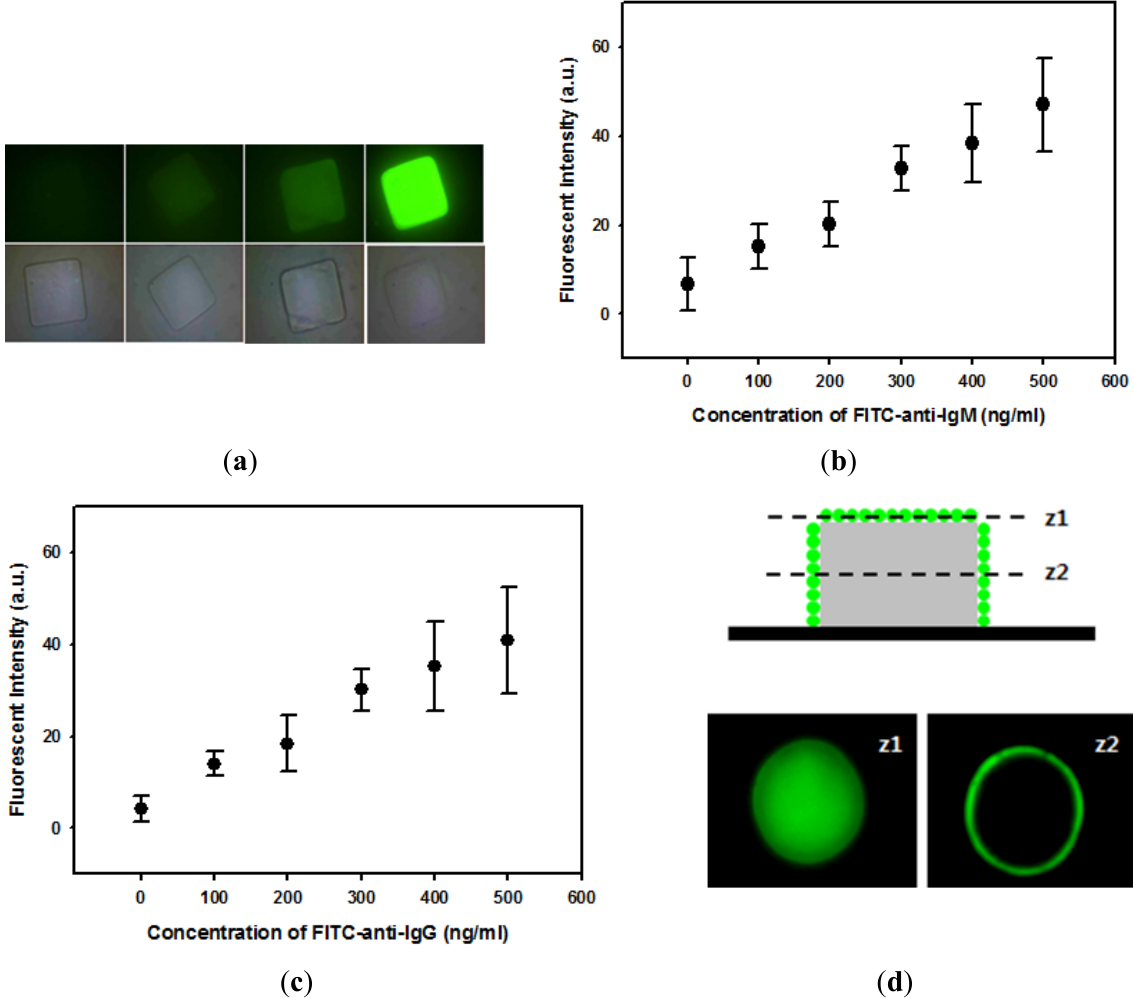
Figure 4. Immunoassays using hydrogel microparticles immobilizing IgG or IgM. ( a ) Optical and fluorescence images of IgM-immobilized hydrogel microparticle that reacted with different concentration of FITC-labeled anti-IgM. ( b ) Relationship between concentration of anti-IgM and the fluorescence intensity. ( c ) Relationship between concentration of anti-IgG and the fluorescence intensity. ( d ) Confocal slice images at different z position (z1,